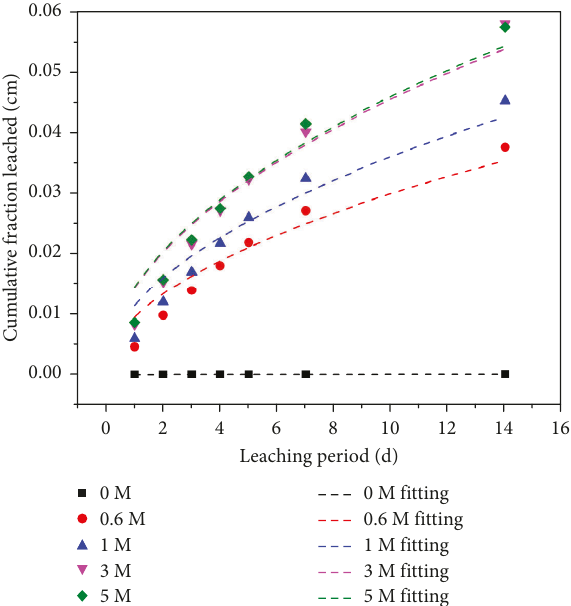
Figure 9: Fitting curve of CFL of Sr 2+ in fly ash/cement waste forms at 20 ° C. Table 5: ADC of Sr 2+ ( D sr ) and time for complete leaching ( T end